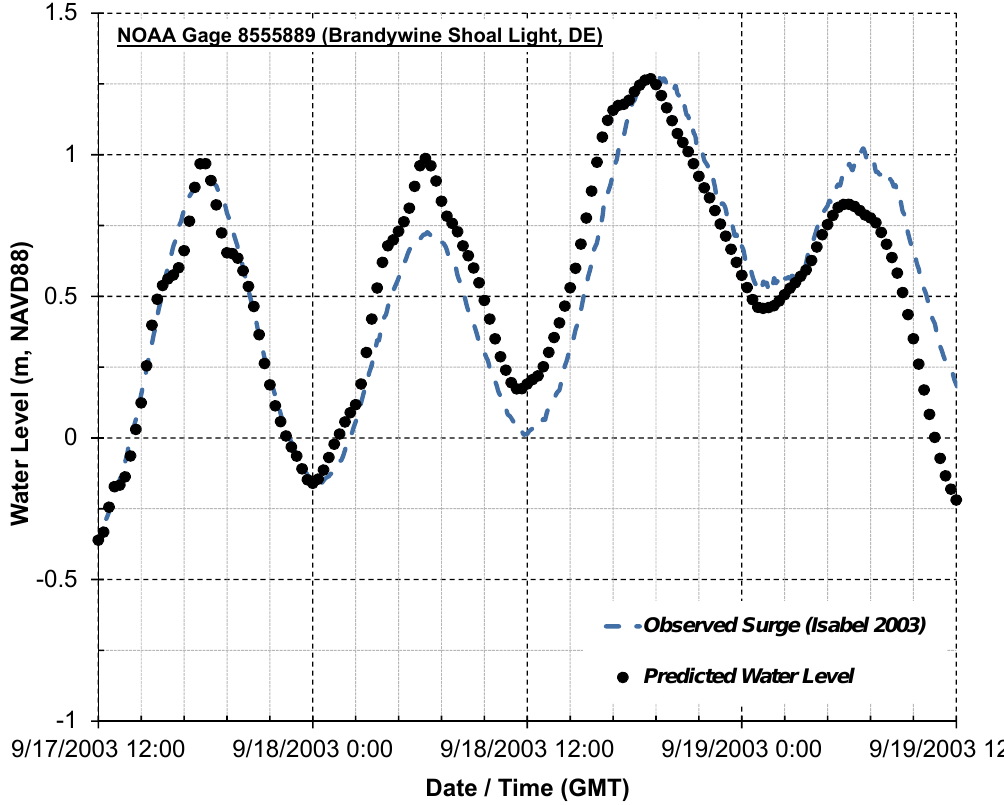
Figure 9. Comparison of calculated and observed water level at Brandywine Shoal Light,